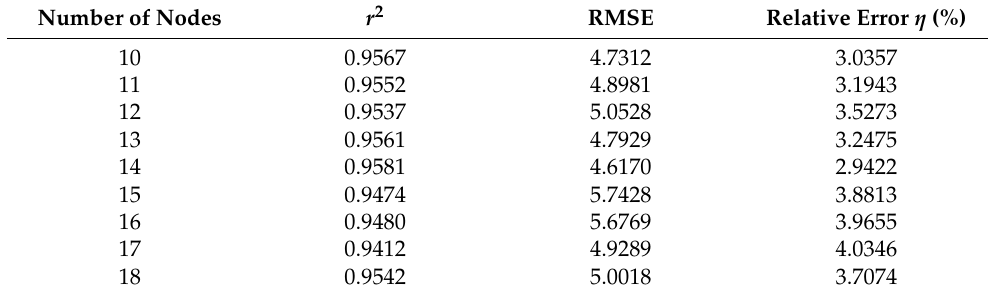
Table 2. Analysis on performance of neural network with different number of hidden layer